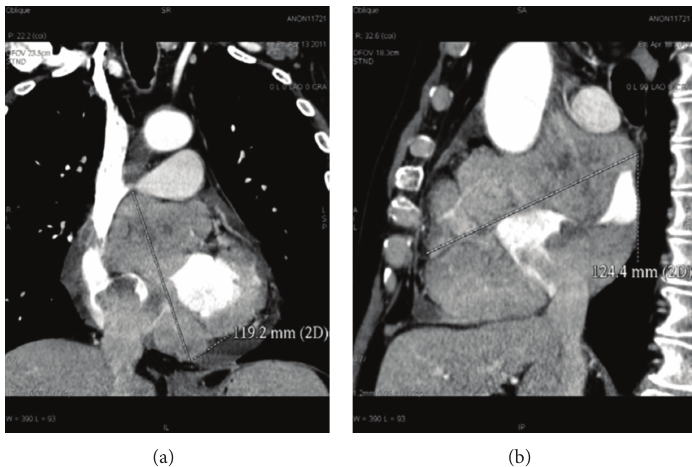
Figure 1: (a) Coronal reconstruction; (b) sagittal reconstruction. CT shows the presence of a 119.2 mm × 124.4mm right atrium myocardial mass, involving the auricle and the atrial septum.